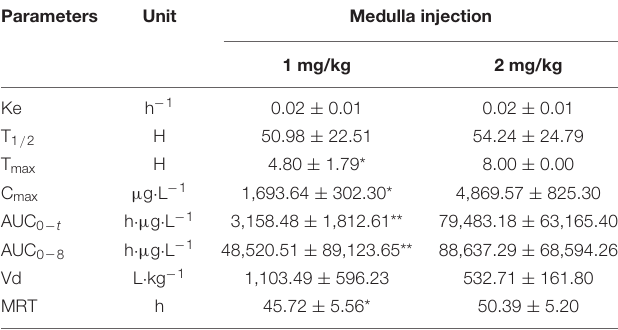
TABLE 1 | Pharmacokinetic parameters for adiponectin (ADPN) in SD rats.